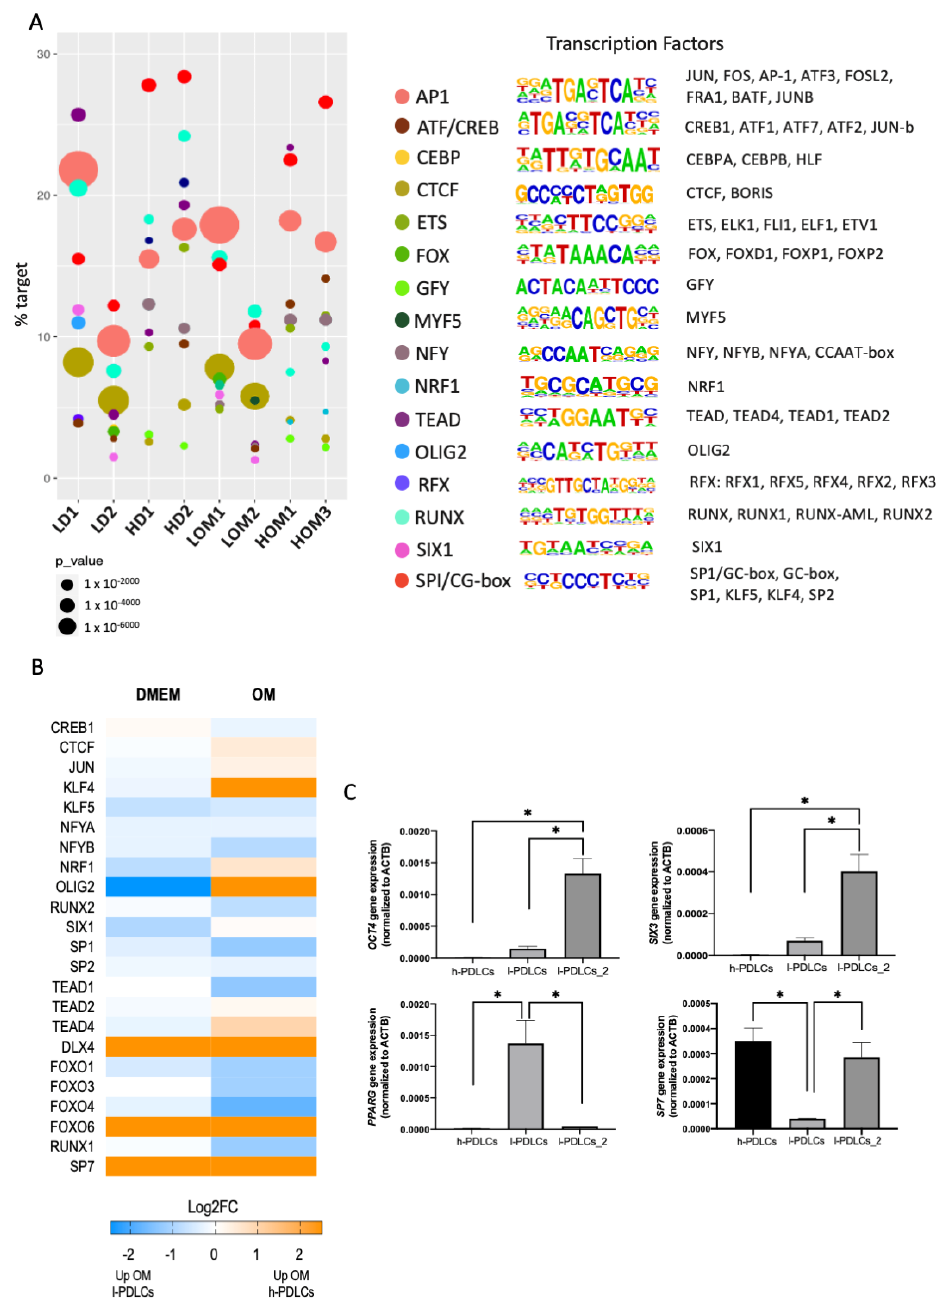
Figure 7. Transcription factor analysis in PDLCs with distinct osteogenic potential. ( A ) ATAC-seq peaks data were used to identify enriched TF motifs in l-PDLCs and h-PDLCs either at basal level or following osteogenic stimulation. The TFs that matched the same de novo motif, were grouped